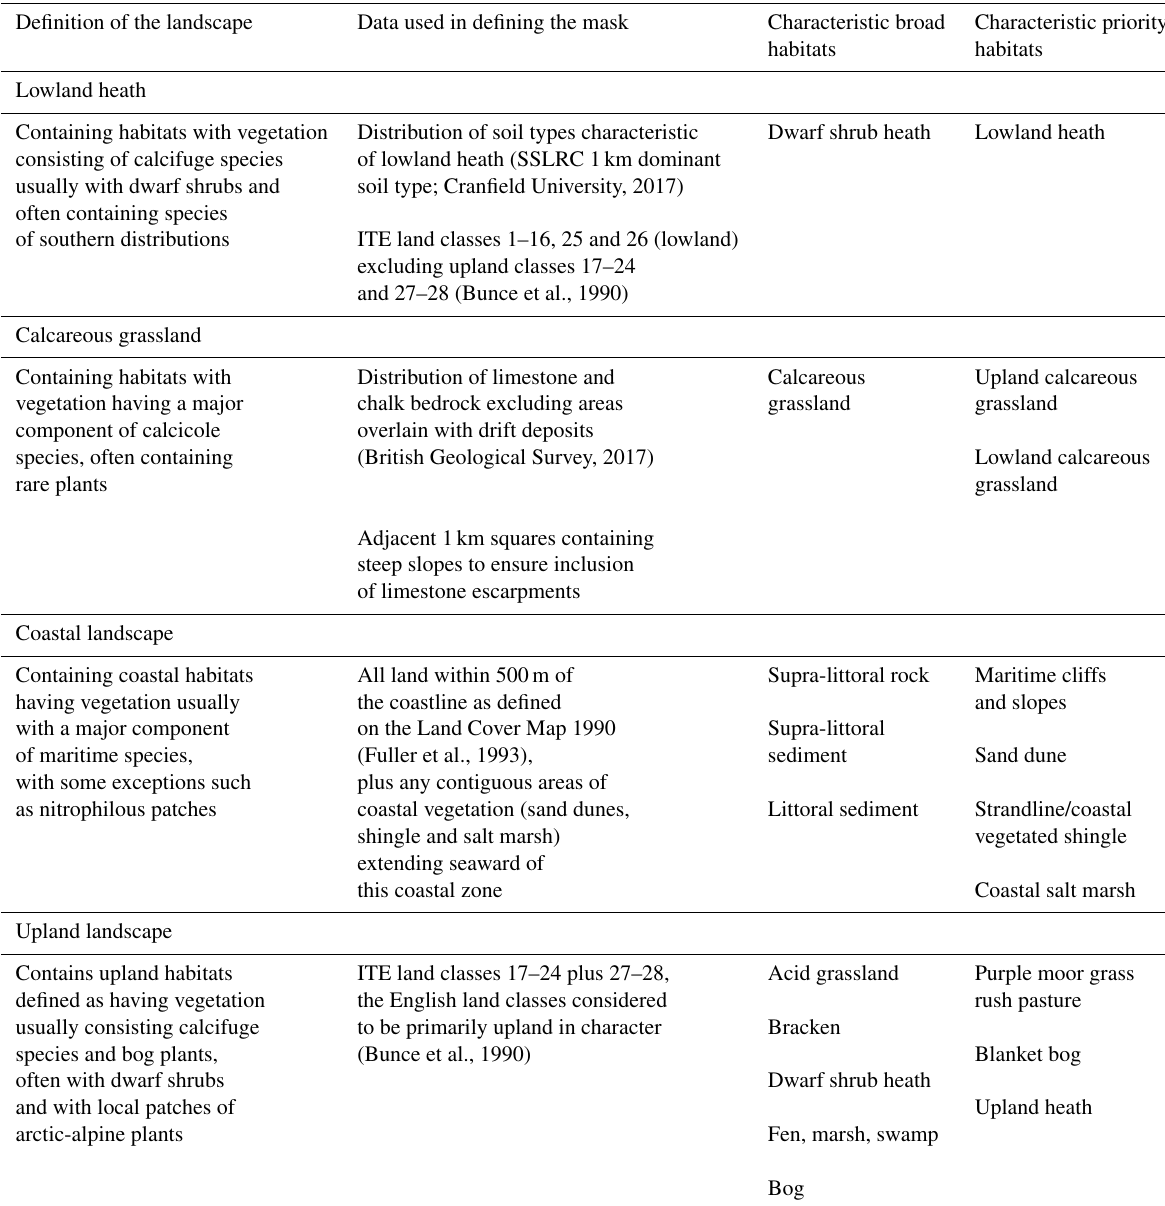
Table 2. Summary of the spatial landscape mask definitions. SSLRC is the Soil Survey and Land Research Centre Definition of the